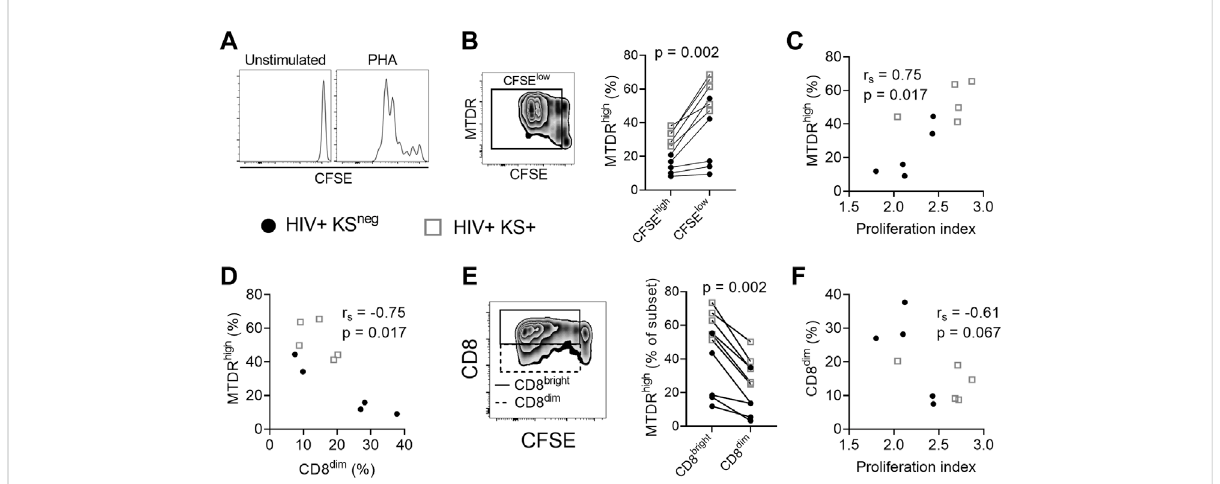
FIGURE 2 Mitochondrial activity is reduced in CD8 dim proliferating cells. (A) Histograms showing CFSE dilution in unstimulated and PHA-stimulated CD8 T cells. (B) MitoTracker Deep Red (MTDR) fl uorescence in PHA-stimulated proliferating (CFSE low ) cells. A signi fi cantly higher percentage of proliferating (CFSE low )CD8TcellsareMTDR high compared withnon-proliferating(CFSE high )CD8Tcells, indicating that proliferating cells havehigher mitochondrial activity ( n = 10; median of differences = 23.25%; Wilcoxon signed-rank test). (C) Positive association between mitochondrial activity (% MTDR high ) of all CD8 T cells in the culture and the proliferation index of proliferating cells in response to PHA stimulation (Spearman correlation). (D) Negative association between mitochondrial activity and the frequency of CD8 dim T cells following stimulation with PHA (Spearman correlation). (E) The frequency of MTDR high cells, comparing CD8 bright and CD8 dim proliferating (CFSE low ) cells. CD8 dim proliferating cells are signi fi cantly less likely to be MTDR high , indicating lower mitochondrial activity (median of differences = − 23.35%; Wilcoxon signed-rank test). (F) Proliferation index of PHA-stimulated CD8 T cells versus the frequency of CD8 dim T cells in the culture (Spearman correlation). Gray open squares, HIV+ KS+ participants; black circles, HIV+ KS neg